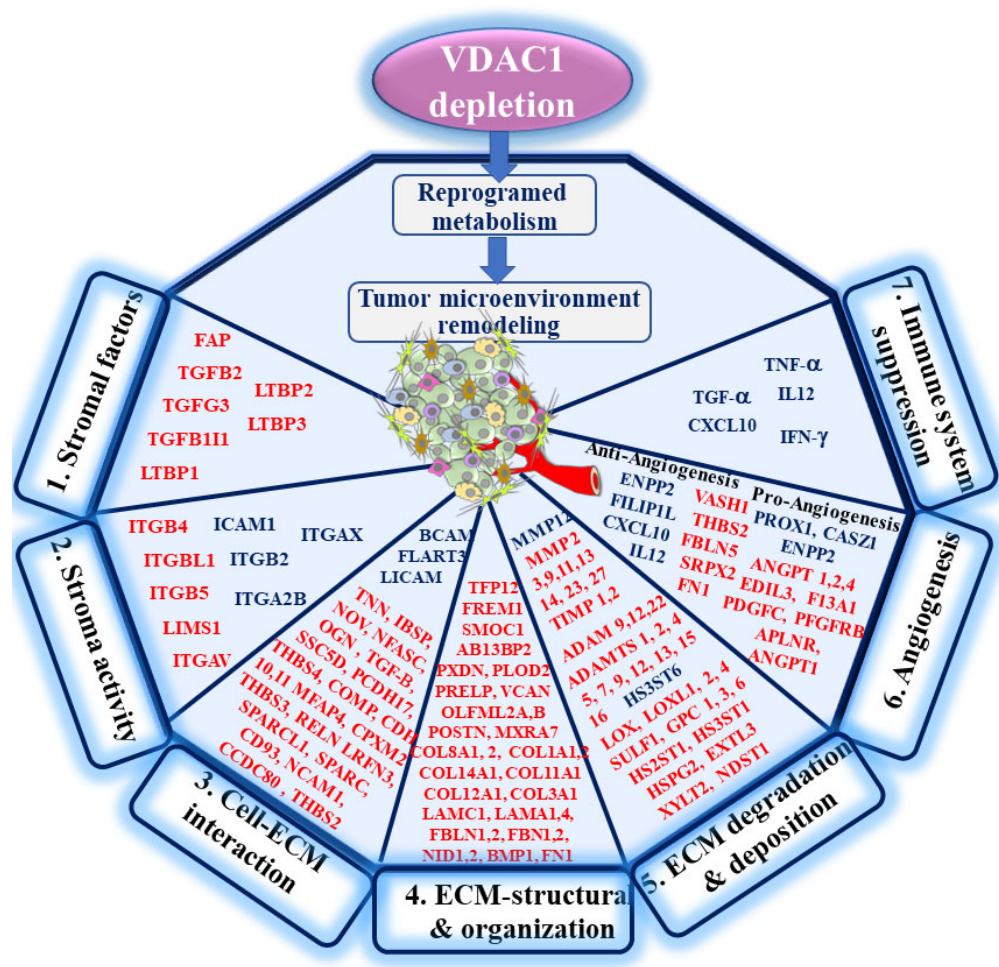
Figure 10. A schematic presentation of mitochondrial VDAC1 depletion and metabolic reprogramming leading to TME remodeling in A549-derived tumors. The overexpressed VDAC1 in mitochondria affects the homeostatic energy and metabolic states of cancer cells. Silencing hVDAC1 expression leads to a reprogramming of metabolism and to TME remodeling. This is reflected in alterations in the expression of genes related to: 1. stromal factors, 2. stroma activity, 3. cell–ECM interactions, 4. ECM structure and organization, 5. ECM degradation and deposition, 6. angiogenesis, and 7. immune system suppression. In each group, the major genes with enhanced expression (blue) or reduced expression (red) are presented. As tumor progression requires a cooperative interplay between host and cancer cells, and the ECM is intensively remodeled during cancer progression, VDAC1-induced alteration in the whole spectrum of TME-related genes affects both the tumor and reciprocal feedback between ECM molecules, host cells, and cancer cells. Tumors can influence the microenvironment by releasing extracellular signals, promoting tumor angiogenesis and inducing peripheral immune tolerance, while the tumor surrounding the microenvironment as immune cells can affect the growth and evolution of cancerous